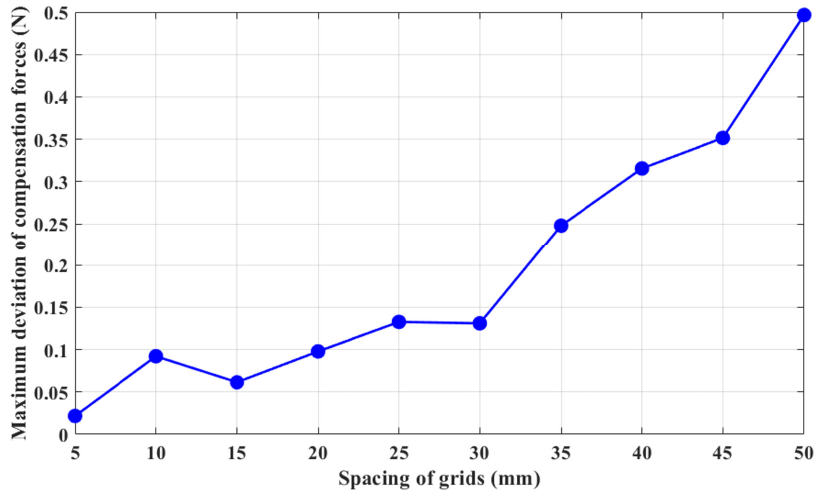
Figure 8. Deviations of compensation force with different grid spacings.